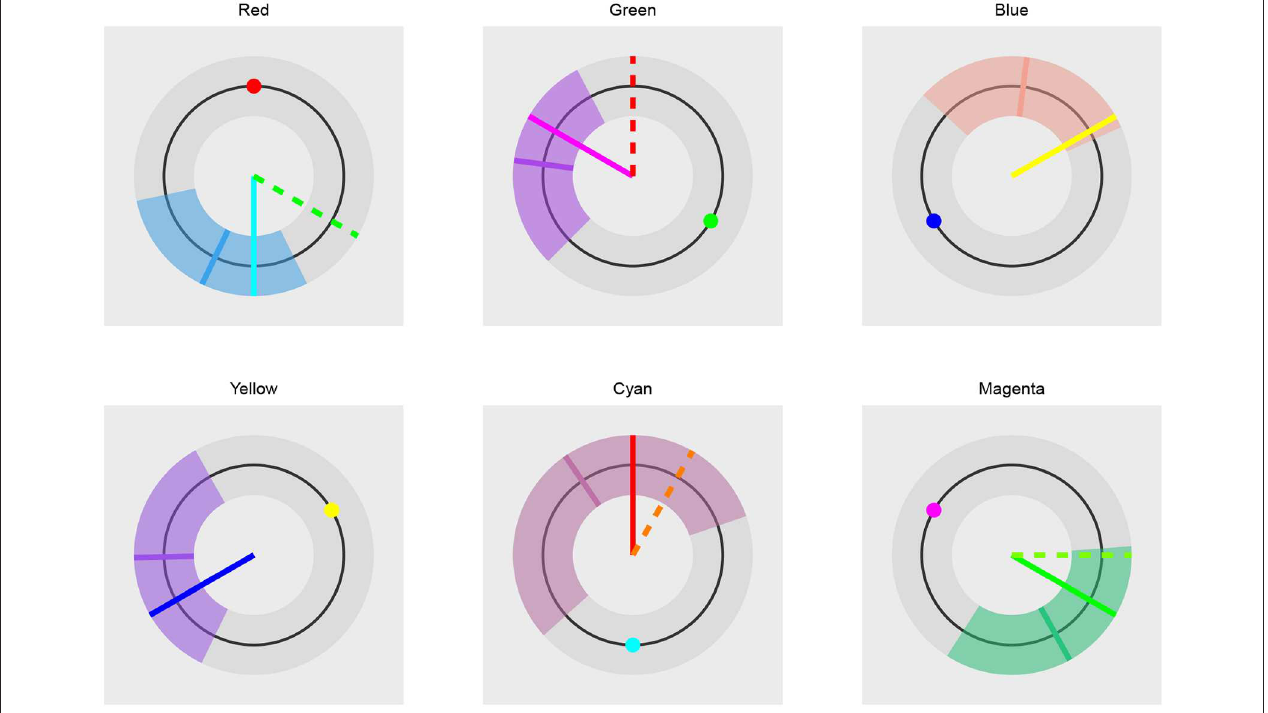
FIGURE 15 | The comparison of trichromatic and opponent-process color coding prediction. The long solid line visualizes the trichromatic color coding prediction. The dashed line visualizes the opponent-process color coding prediction. Short solid line represents the mean hue of the fit. The colored band the 95% HDI of the distribution underlying the fit. The small colored circle visualizes the color of the presented stimuli. In the case of blue and yellow stimuli the dashed line is not visible because both color codings predict the same outcome. The prediction based on the trichromatic color coding seems more accurate as its prediction is always inside the 95% of the most probable subject’s responses and is always closer to the mean predicted hue than the opponent-process prediction. The opponent-process prediction is outside of the 95% of the most probable subject’s responses in cases of red and green stimuli.